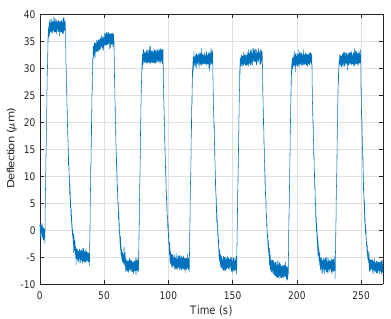
Figure 21: 2-axis trunnion: least square fit on data in a single load cycle. Load in y-dir, at posi- tion 4. With active servos (L), With active Brakes (R).